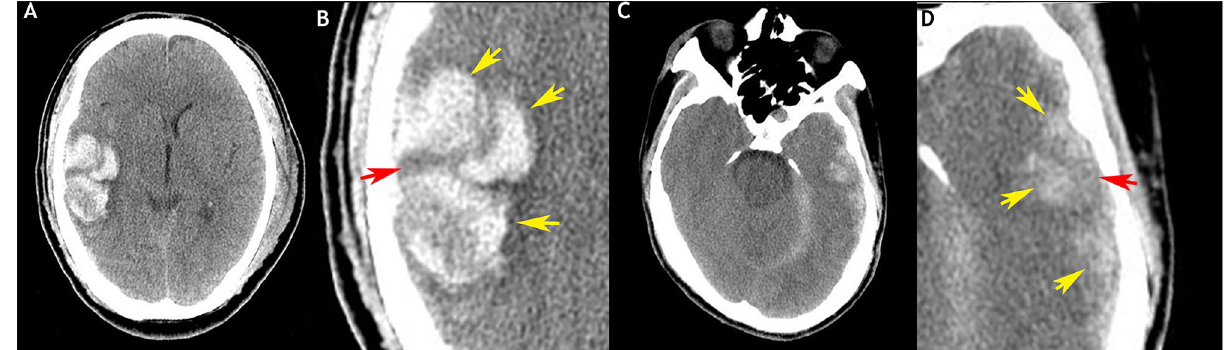
Figure 2. Illustration of multihematoma fuzzy signs on baseline CT, showing two representative multihematoma fuzzy signs in the contusion region ( A , C ) and their respective local zones ( B , D ). Axial sections of CT reveal three relative hyperdense hematomas adjacent to each other (yellow arrows) in the contusion regions and the presence of a relative hypodense fuzzy signal (red arrows) on the area between the